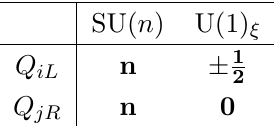
Table 2 . Field content of a CP-violating sector, with (cid:13)avor indices i; j = 1 ;